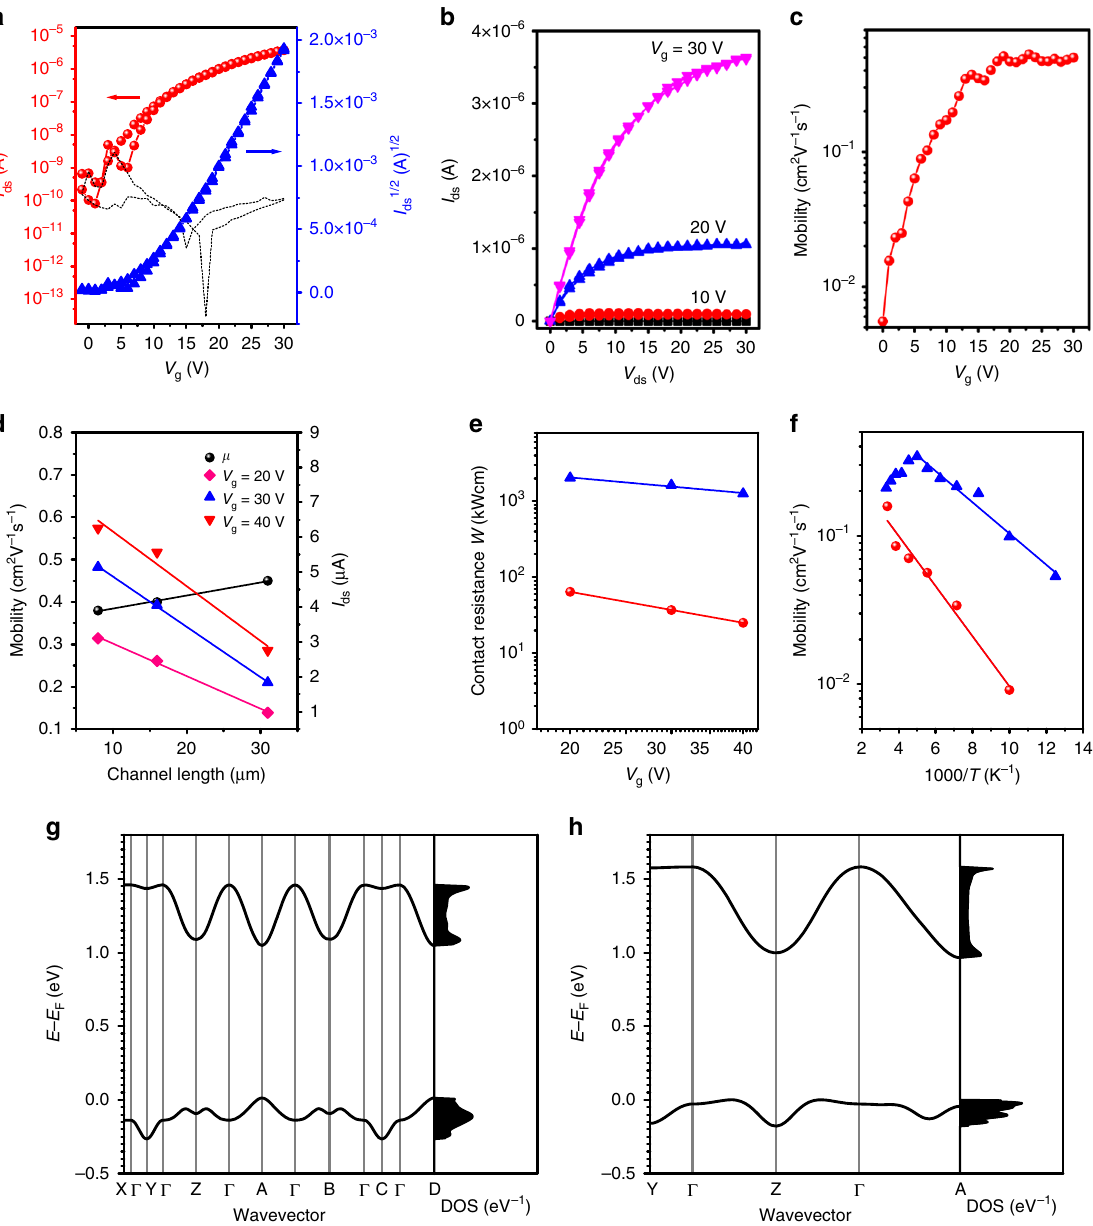
Fig. 3 Electrical properties of MMC FETs. a , b Transfer and output curves of MMC devices on BCB/SiO 2 substrates (in a , the dashed black line is the leakage current). Here the channel width and length are 131 and 19 μ m, respectively, and the saturation mobility is 0.51 cm 2 V − 1 s − 1 . c The extracted fi eld- effect mobility as a function of V g at V ds = 30 V for the same device. d Electron mobility and drain current of the MMC FETs at different channel lengths on BCB/SiO 2 . e Contact resistance of MMC FETs (red ball) and FETs based on the thick crystal with thickness of 40 nm (blue triangle) at different gate voltages on BCB/SiO 2 . f Temperature-dependent mobility of the MMC on SiO 2 (red ball) and BCB/SiO 2 (blue triangle). g , h Band structures and density of states (DOS) of the fully optimized bulk ( g ) and monolayer crystals ( h ). The high-symmetry points in the fi rst Brillouin zone are labeled as follows: Г = (0,0,0), X = (0.5,0,0), Y = (0,0.5,0), Z = (0,0,0.5), A = (0,0.5,0.5), B = (0.5,0,0.5), C = (0.5,0.5,0), and D = (0.5,0.5,0.5), all in crystallographic coordinates. The Fermi energy is taken as the origin of the energy